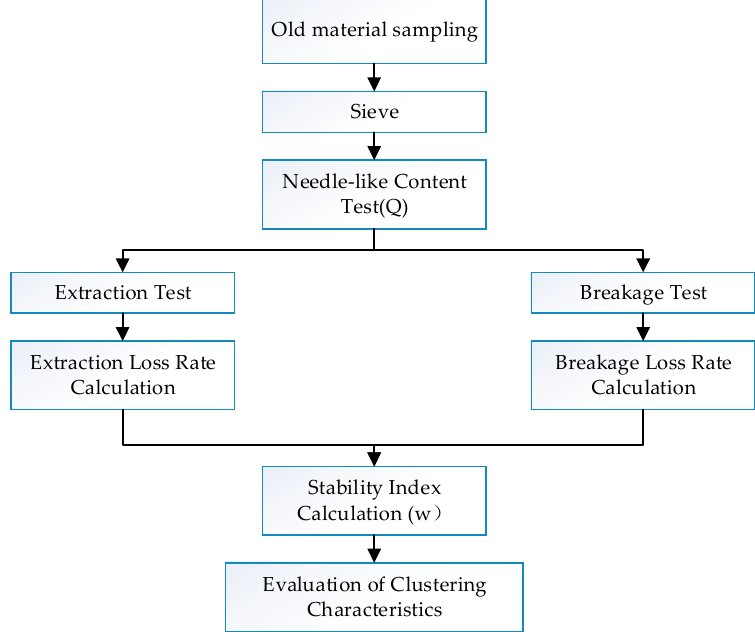
Figure 3. A flow chart of the evaluation method